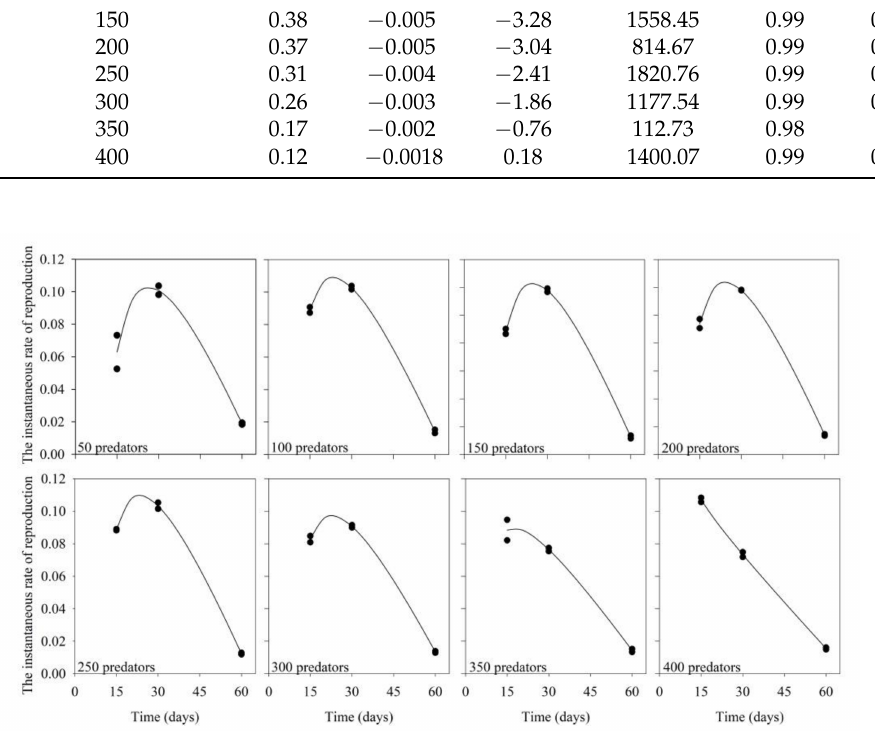
Figure 3. Instantaneous rate of reproduction of the predator Amblyseius tamatavensis produced in each 500 mL containers at different production periods on Thyreophagus cracentiseta , for different levels of predator inoculation (25 ± 1 ◦ C, 70 ± 10% RH, in the